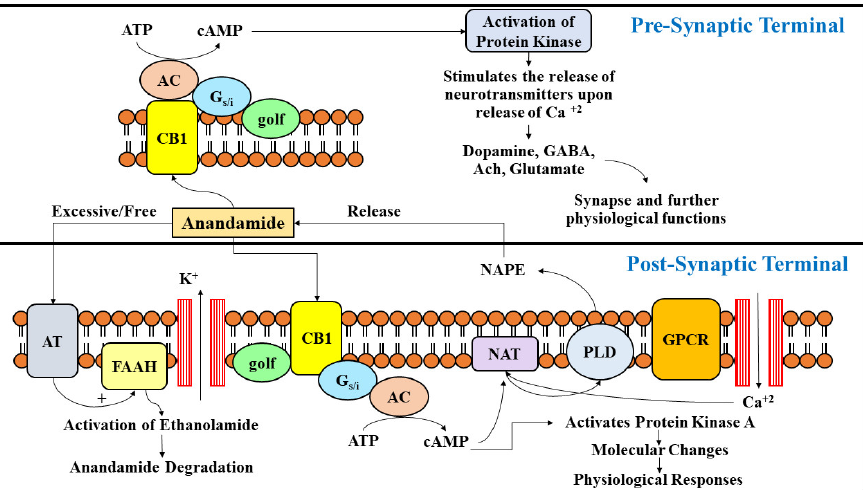
anandamide upon activation of phospholipase D and further stimulation of GPCR. NAT is a catalytic enzyme which hastens the biosynthesis of NAPE upon release of cAMP and calcium ions. Upon activation of cannabinoid receptors at presynaptic sites, they are released into synapse and further initiate the release of several neurotransmitters which control and modulate various physiological functions in the body. The excitation of neurons is also regulated upon nodulation of the potassium cellular uptake via anandamide transporter or its degradation upon activity of FAAH